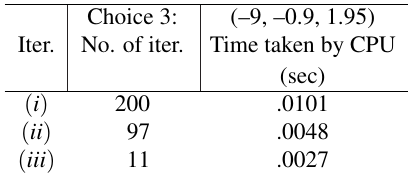
Table 2. For Choice 3, comparison for the sequences defined in Theorems